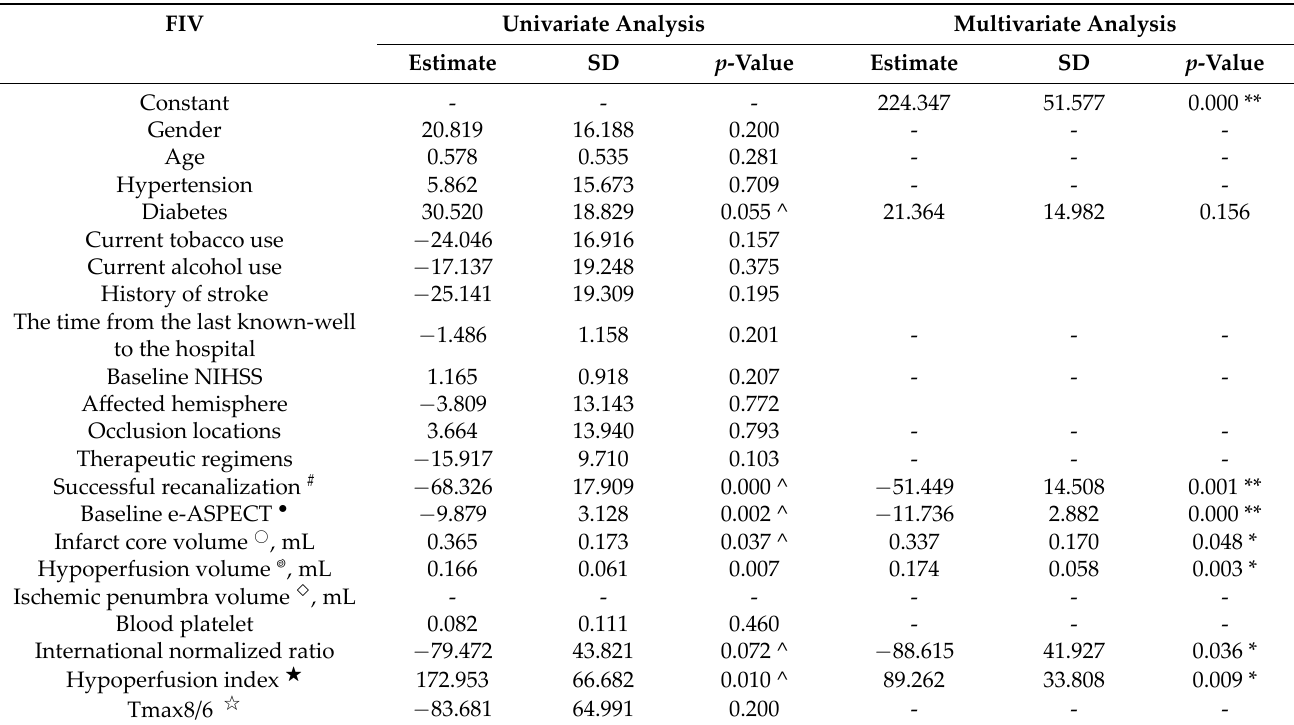
Table 3. Uni‑ and multi‑variate analysis using the linear mixed effect model for FIV.